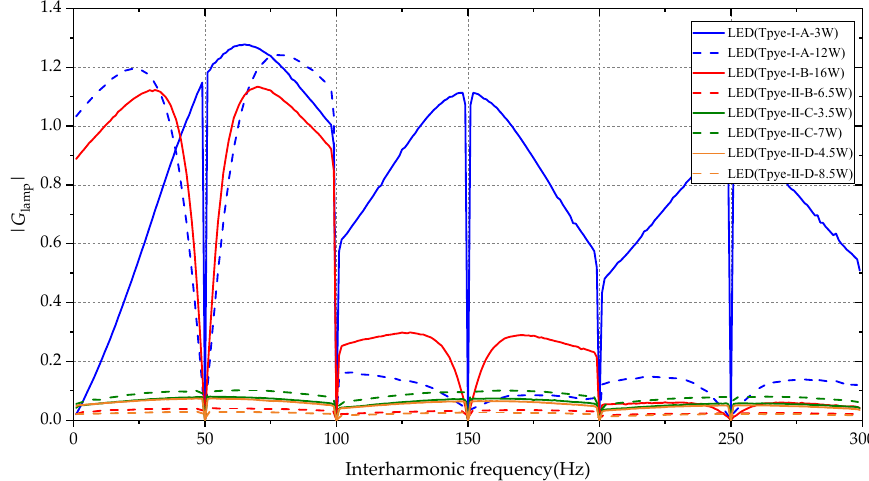
Figure 7. Interharmonic voltage and luminous flux fluctuation transfer coefficient of test LED lamps.